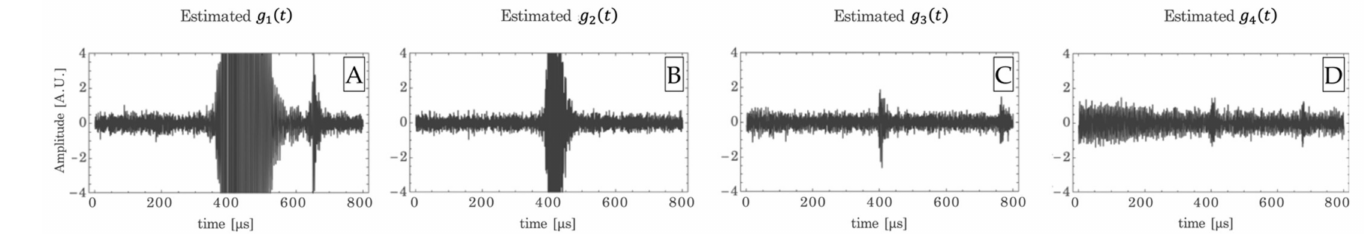
Figure 8. Non-contact point focused ultrasonic probes experiment: g i ( t ) functions for the four orders considered (expanded representation scale) in the case of the lower SNR value (20 [dB]). Plots ( A – D ): functions g 1 ( t ) , g 2 ( t ) , g 3 ( t ) , g 4 ( t ) , respectively.